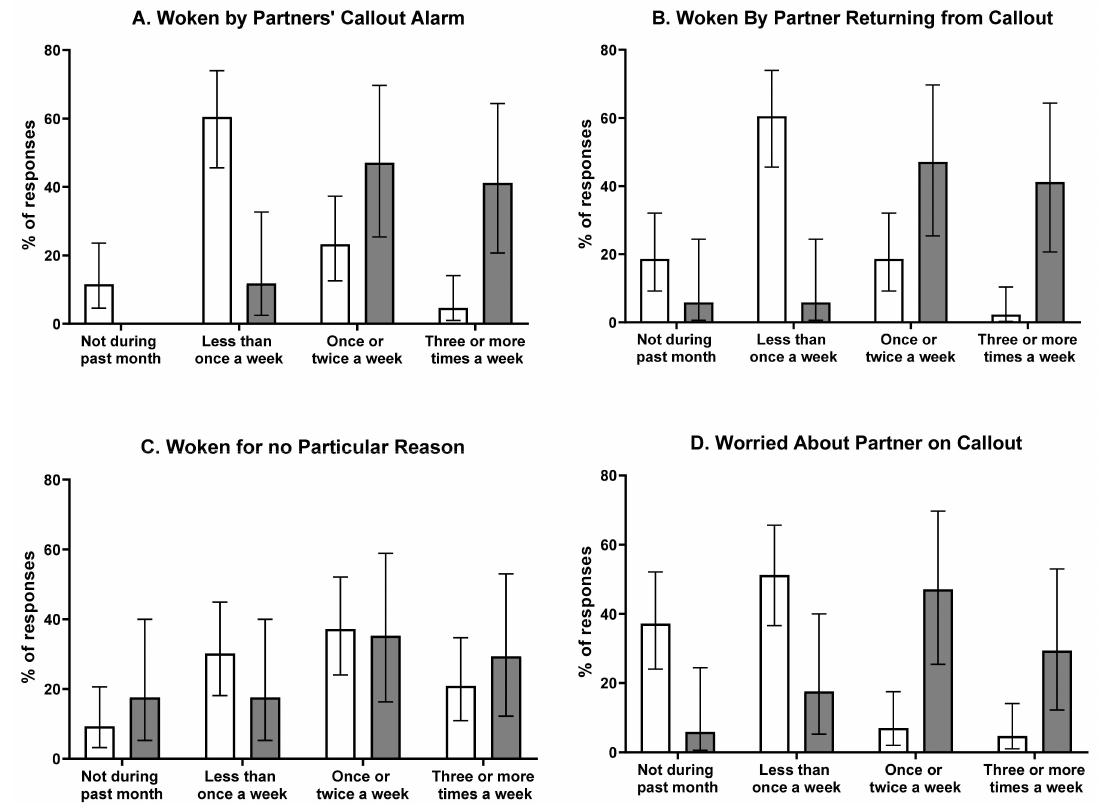
Figure 1. Reasons participants had trouble sleeping. Figures represent % of participants with 95% confidence